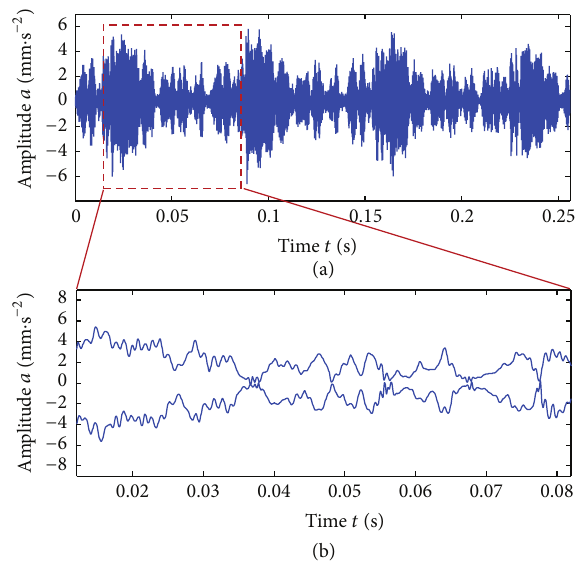
Figure 8: The wavelet coefficient at selected subband and its envelope under abnormal